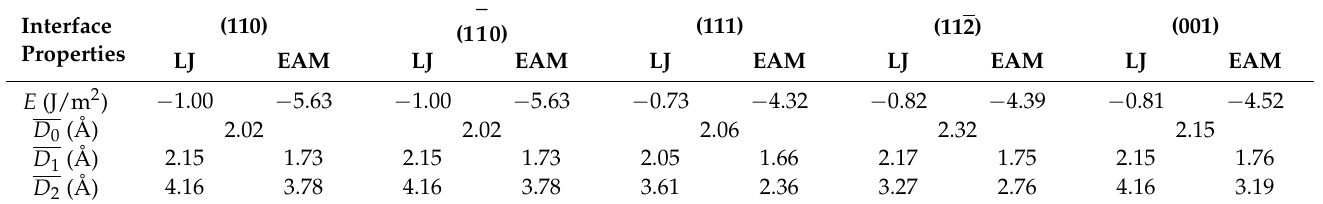
Table 1. Interactive energy ( E ) and average vertical distance ( D 1 , D 2 ) between the graphene nanosheet and the 1st- or 2nd-closed iron atom layer at the interface, where the graphene nanosheet is aligned on different crystallographic plane of iron matrix, and D 0 is the initial setting distance between the graphene and iron